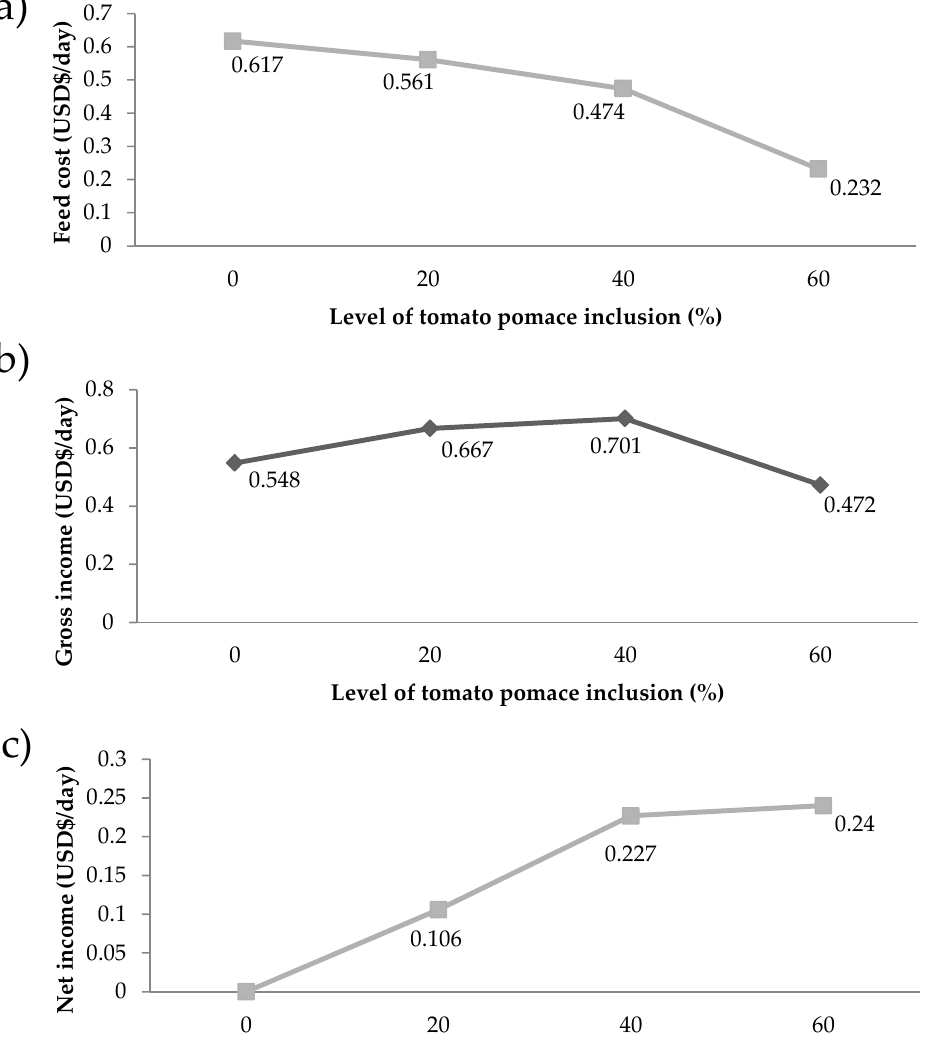
Figure 2. Feeding cost ( a ), gross income ( b ), and net income ( c ) of goat diets with different levels of tomato pomace.